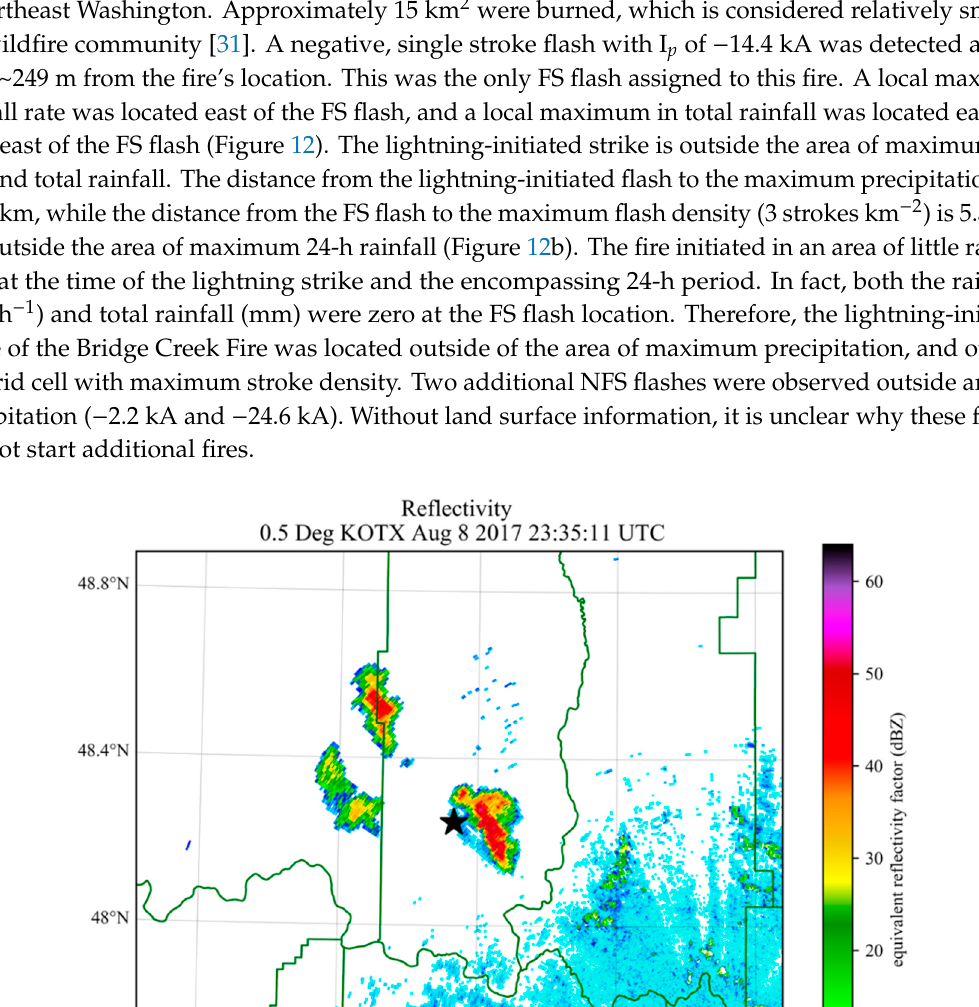
Figure 12. Plots of a ) rate rain (mm h − 1 ) at 2332 UTC 8 Aug 2017 and b ) 24-h rainfall (mm) from 1200 UTC 8 August 2017 to 1200 UTC 9 August 2017 over the 20 km by 20 km domain centered on the fire start location of the Bridge Creek Fire. The yellow star denotes the location of maximum stroke density, and black (red) circles represent the NFS flashes (FS flash).